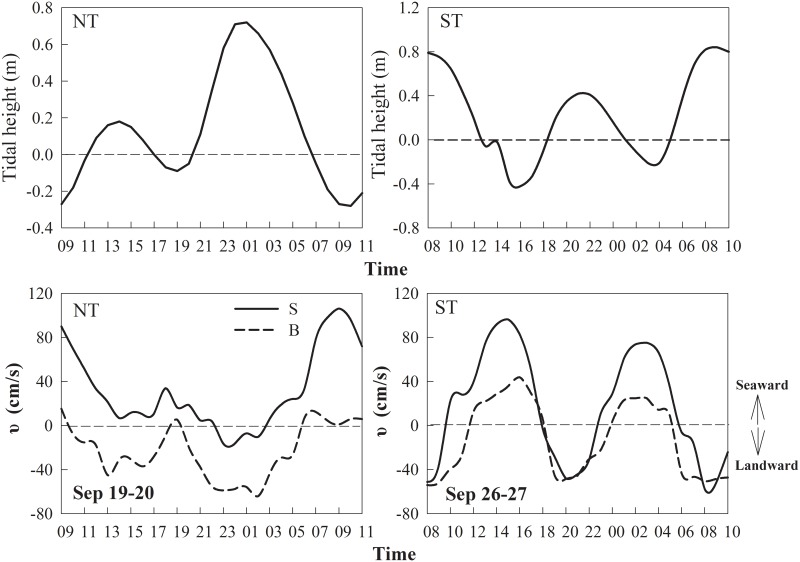
Tidal height (m) and flow velocity (υ, cm/s) variation during NT and ST at the anchor Stn W5.